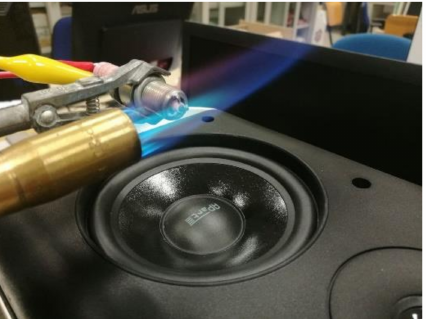
Figure 6. Setup for the acoustic pulsation